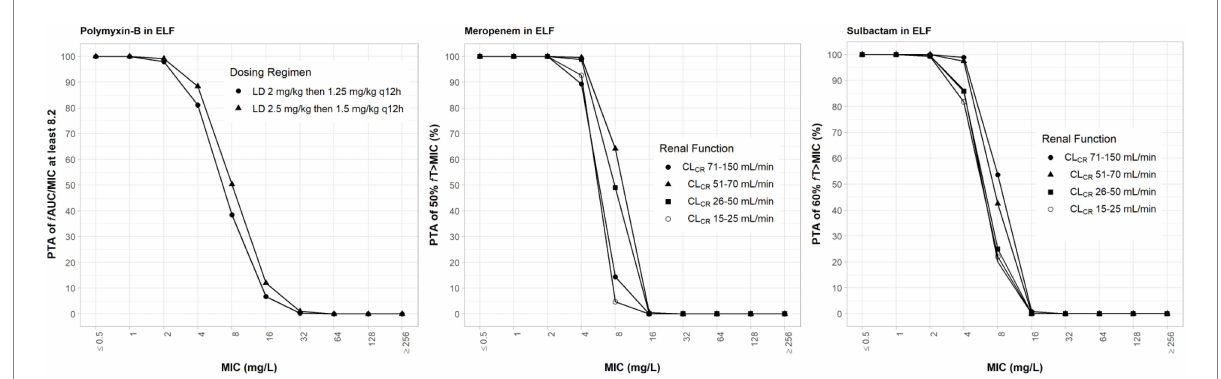
FIGURE 4 Probability of target attainment of 50% f T >MIC and 60% f T >MIC for meropenem and sulbactam dosing regimens, respectively, by renal function categoryand PTA of f AUC/MIC of at least 8.2 for polymyxin-B dosing regimens. Probability of target attainment values were computed based on